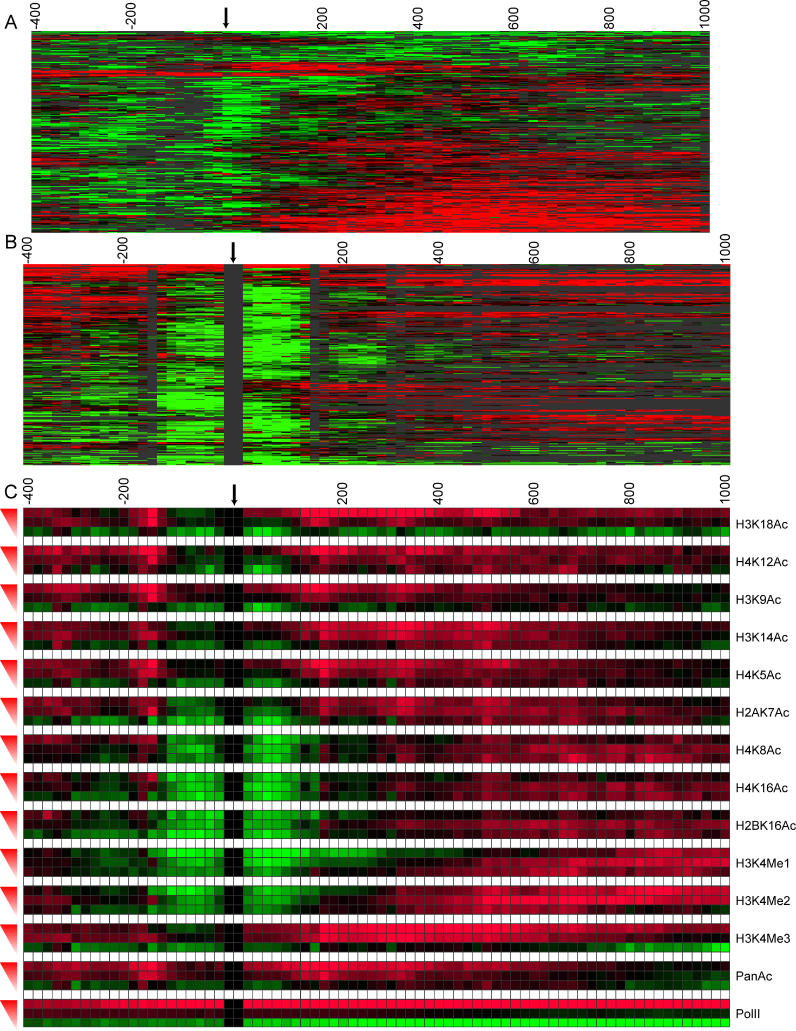
Broad Patterns of Histone Modifications(A) H4K16Ac aligned by ATG. In this representation, the horizontal axis represents location relative to the downstream gene's start codon, and each horizontal line represents one PolII-driven gene. Each cell in the resulting matrix corresponds to the acetylation level at a given microarray probe for one tail position. Red (green) cells mark hyper-acetylated (hypo-acetylated) probes. Non-nucleosomal probes are blackened. We clustered the promoters using a probabilistic agglomerative clustering algorithm (see Materials and Methods). Arrow indicates annotated ATG.(B) H4K16 aligned by transcriptional start site, as in (A), except that arrow indicates TSS (identified in [29]) and data before and after the TSS are aligned by the first nucleosome in that direction.(C) Relationship of histone modification patterns to transcription level. Genes were split into three groups based on PolII enrichment, and averaged data for these groups are shown as indicated, aligned as in (B). Transcription level is indicated by red triangles to the left of each set of three rows.